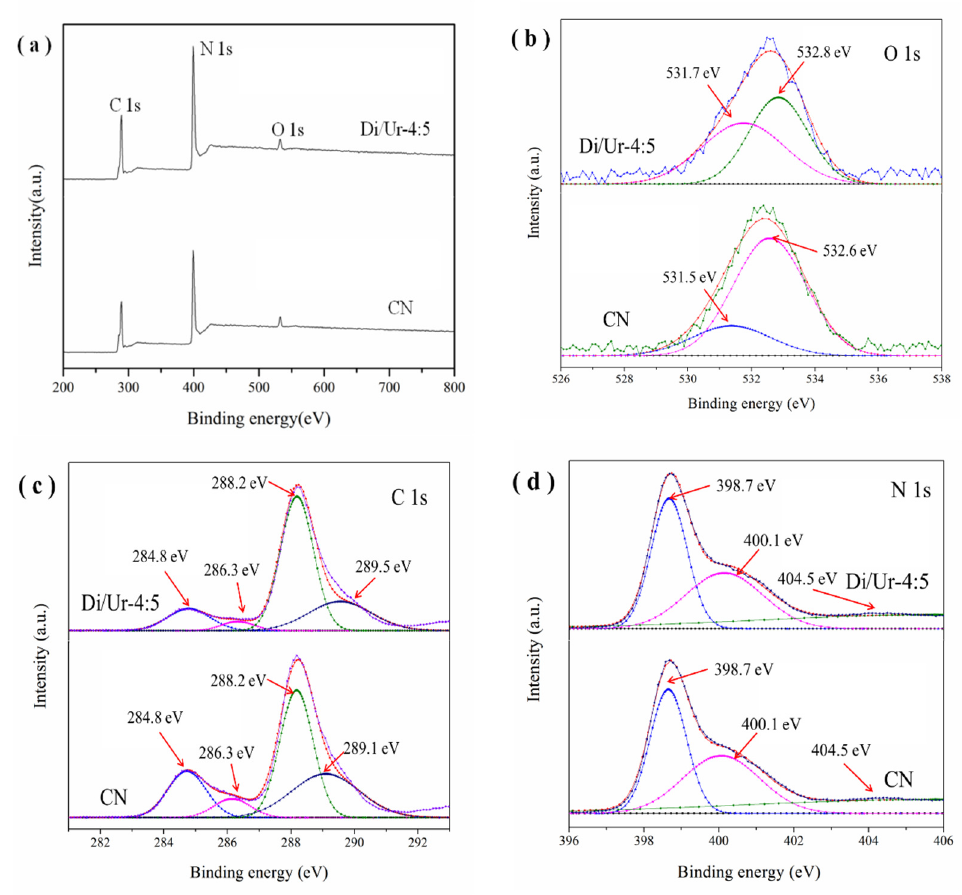
Figure 4. The XPS of Di/Ur-4:5 and CN for ( a ) survey spectrum; ( b ) O 1s; ( c ) C 1s; ( d ) N